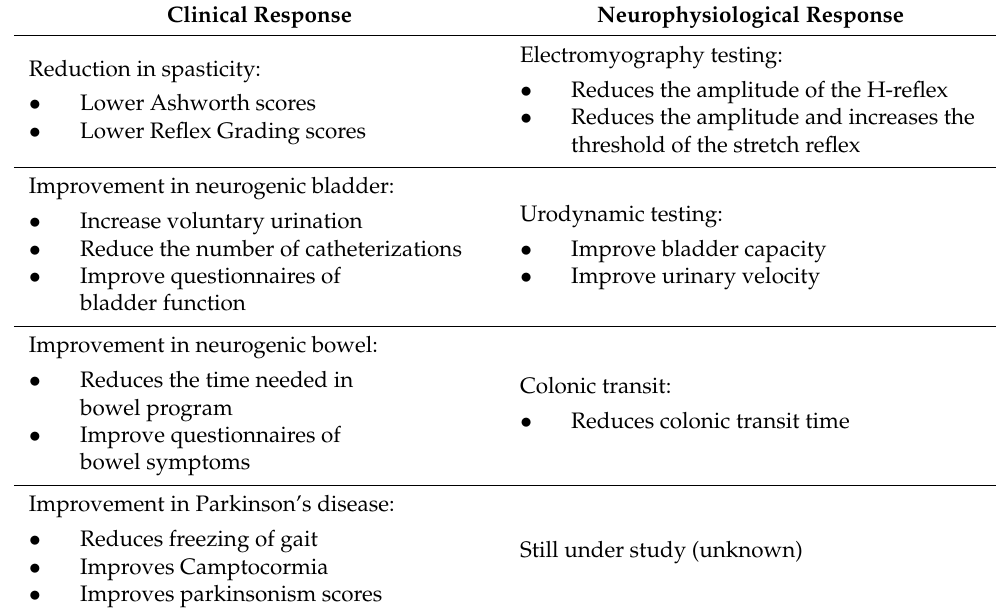
Table 3. Clinical and neurophysiological evidence of spinal cord modulating effects of